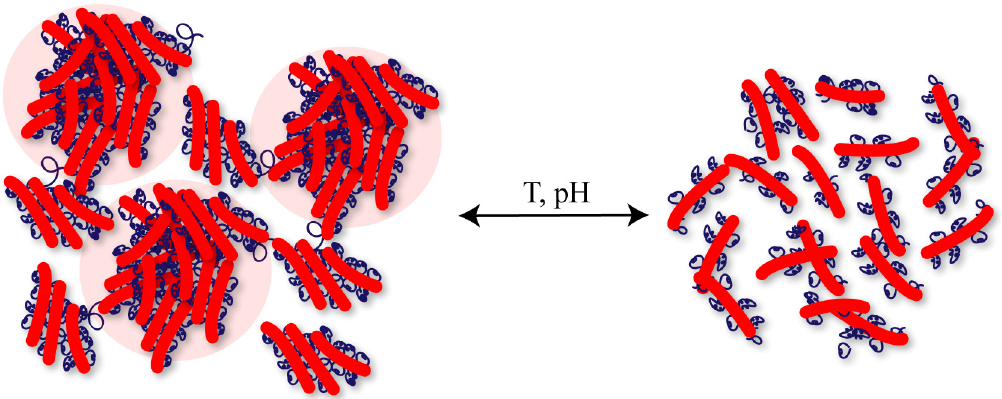
Figure 11. Schematic representation of the gel with microscopic domains of densely cross-linked polymers. Addition of base, or increase in temperature, renders the individual polymer stacks more water-soluble, and induces the disappearance of the cross-links and the mesoscale